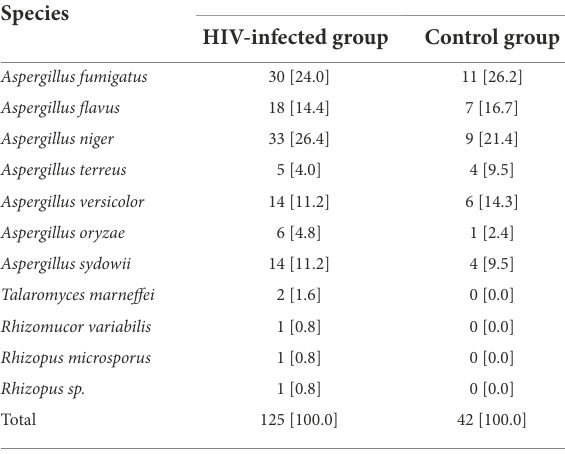
TABLE 2 Identification results of pathogenic filamentous fungi in HIV-infected individuals and healthy controls. Number of Strains Species HIV-infected group